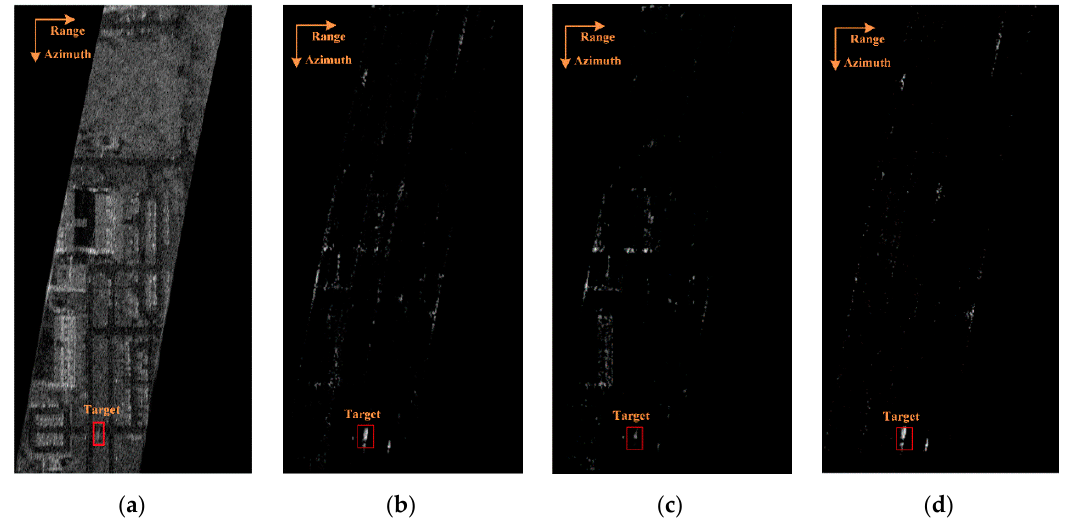
Figure 6. The statistical angle histograms of the interferometric phase: ( a ) before channel equalization and ( b ) after channel equalization.